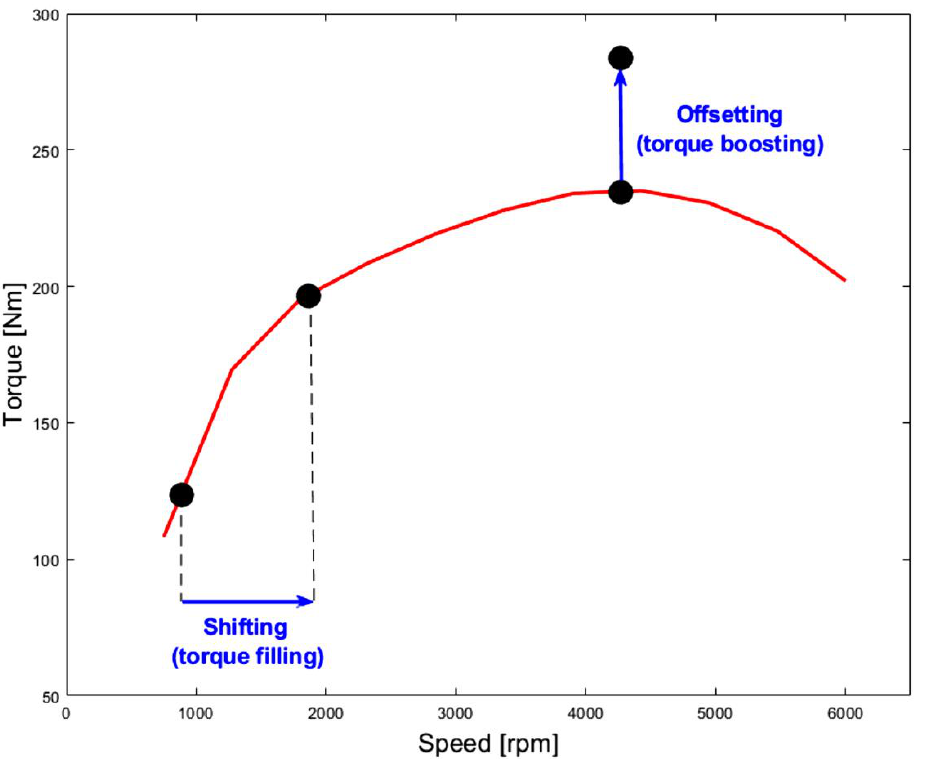
Figure 1. Illustration of internal combustion engine operating point shifting and offsetting [10].